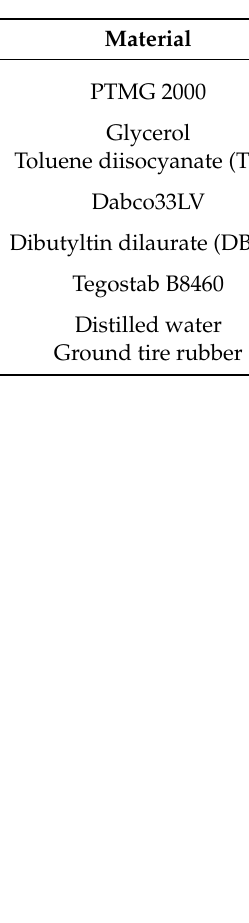
Table 1. Materials used to prepare flexible PU foams in the presented study.